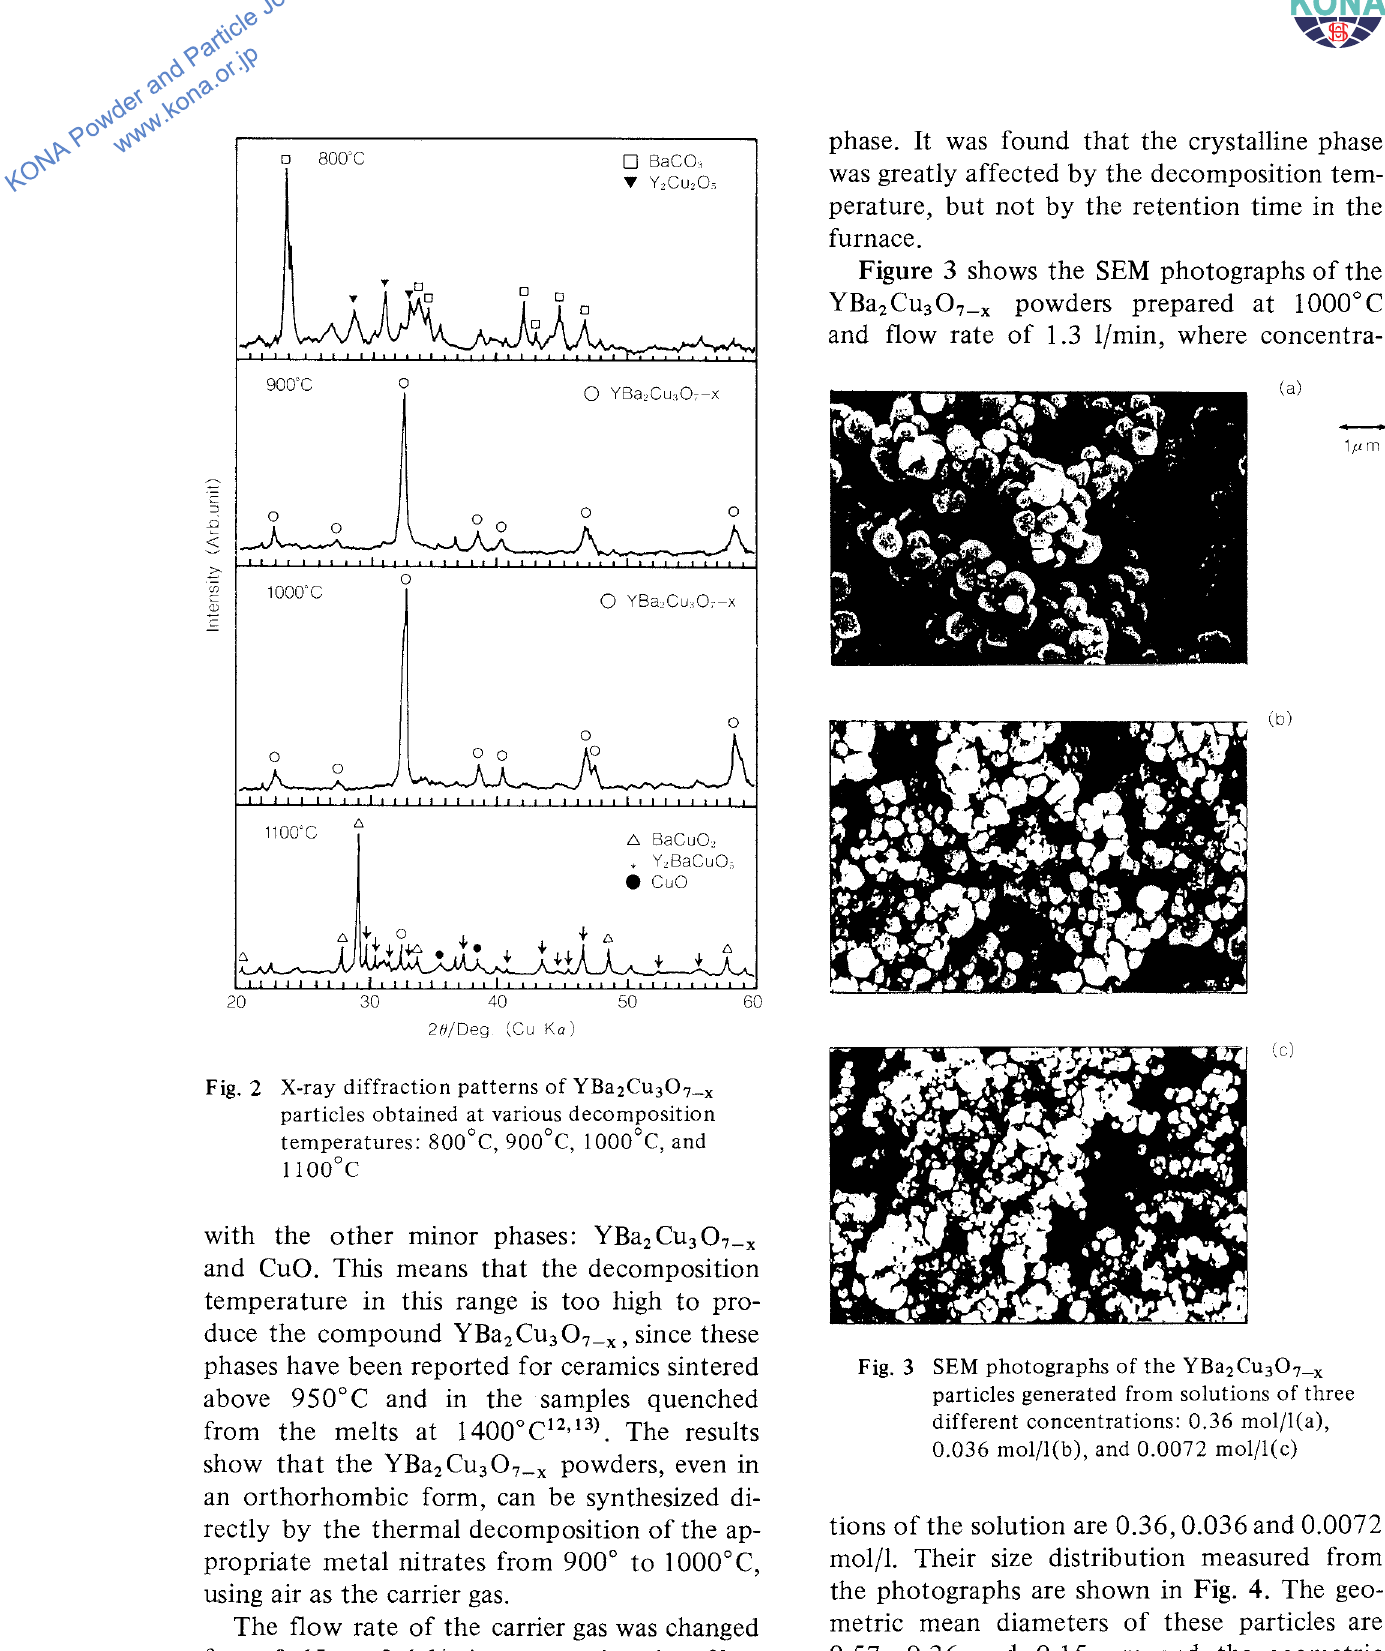
Fig. 2 X-ray diffraction patterns of YBa 2 Cu 3 0 7 _x particles obtained at various decomposition temperatures: 800°C, 900°C, 1000°C, and 1100°C